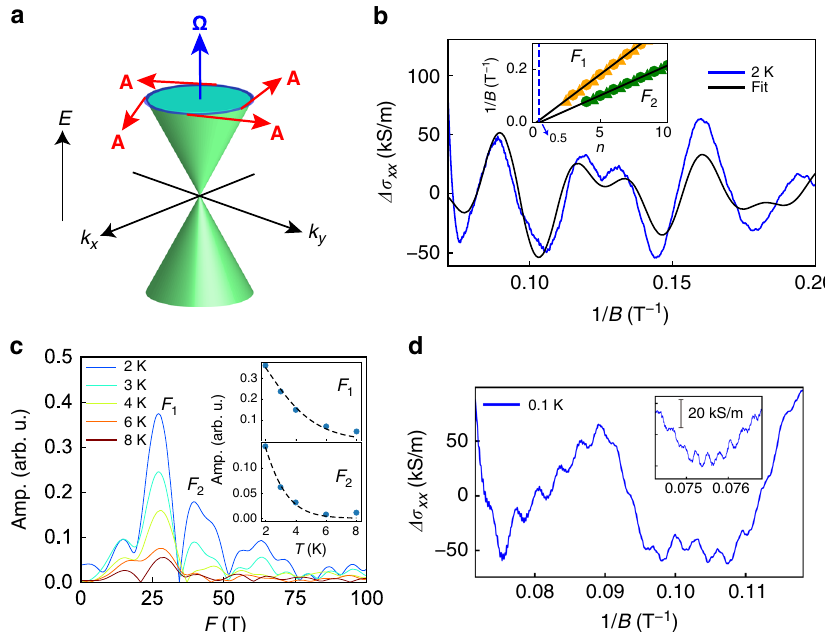
Fig. 3 Quantum oscillations of SrRuO 3 . a Schematic image of energy dispersion near a Weyl point. Blue and red arrows represent the Berry curvature Ω and the Berry connection A , respectively. The π Berry phase is accumulated along the cyclotron orbits (blue circle). b SdH oscillation measured at 2 K with B (5 T < B < 14 T) applied in the out-of-plane [001] direction of the SrTiO fi lm with the RRR of 84.3. Black curve is the fi tting curve 3 substrate for the SrRuO 3 of Eq. (1). The fi tting was carried out by a nonlinear least squares method with the fi tting parameters A 1 , β 1 , T D 1 , A 2 , β 2 , and T D 2 . The inset shows fan diagrams of two oscillation components of F 1 ( = 26 T) and F 2 ( = 44 T), which are shown as orange and green symbols, respectively. Here, the circles and triangles indicate integer and half-integer indexes of the oscillation components. c Fourier transform spectra of the SdH oscillations at 2 – 8 K. Insets in c show the mass estimations of the F 1 and F 2 orbits according to the LK theory. Black dashed curves are the fi tting curves. d SdH oscillation observed at 0.1 K for the SrRuO 3 fi lm with the RRR of 84.3. The inset in d shows a close-up at around 0.075T − 1 . The oscillation holds four kinds of other trivial orbits with higher